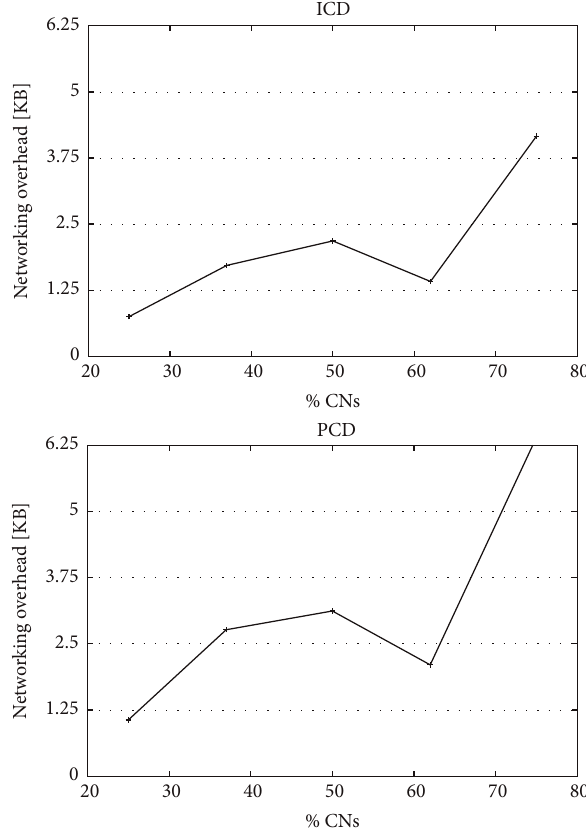
Figure16:AveragenetworkingoverheadmeasuredinICDandPCD against different ratios of CNs within the